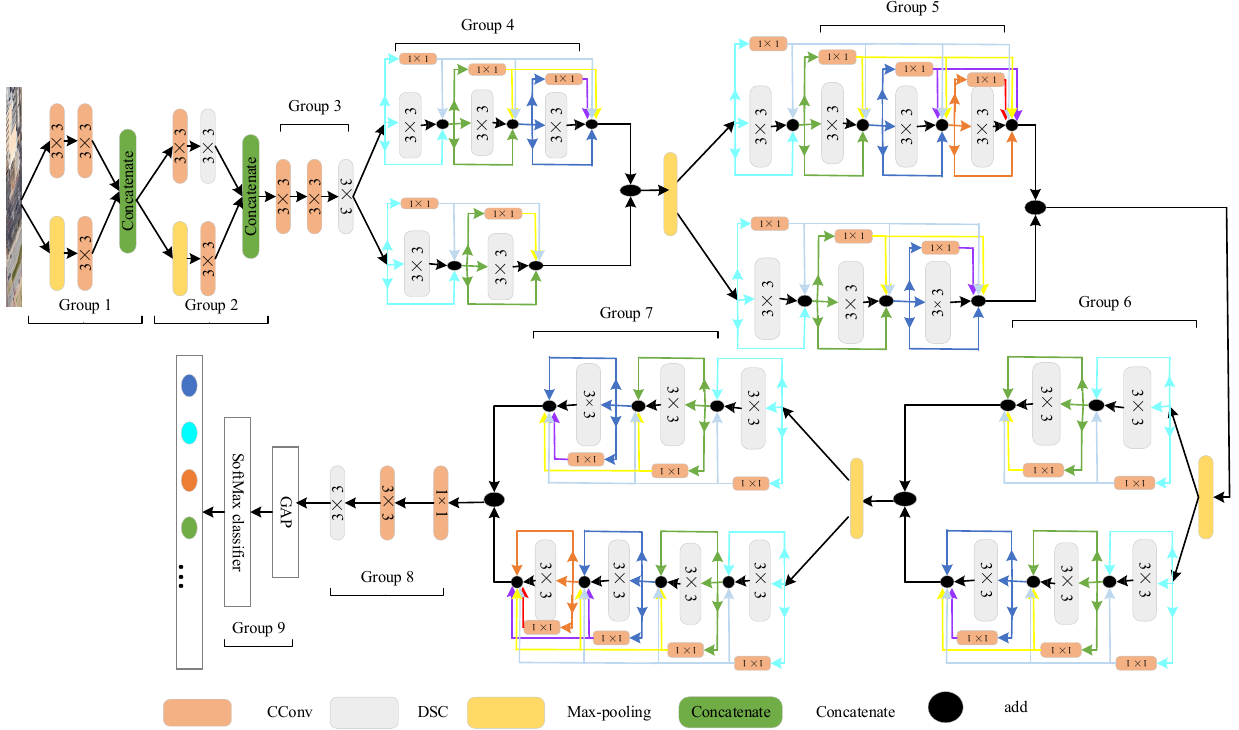
Figure 1. The proposed BMDF-LCNN network model.